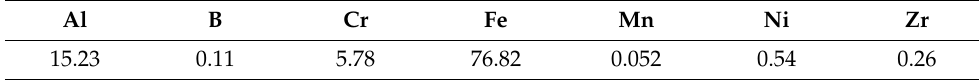
Table 1. Chemical composition of Fe 3 Al powder